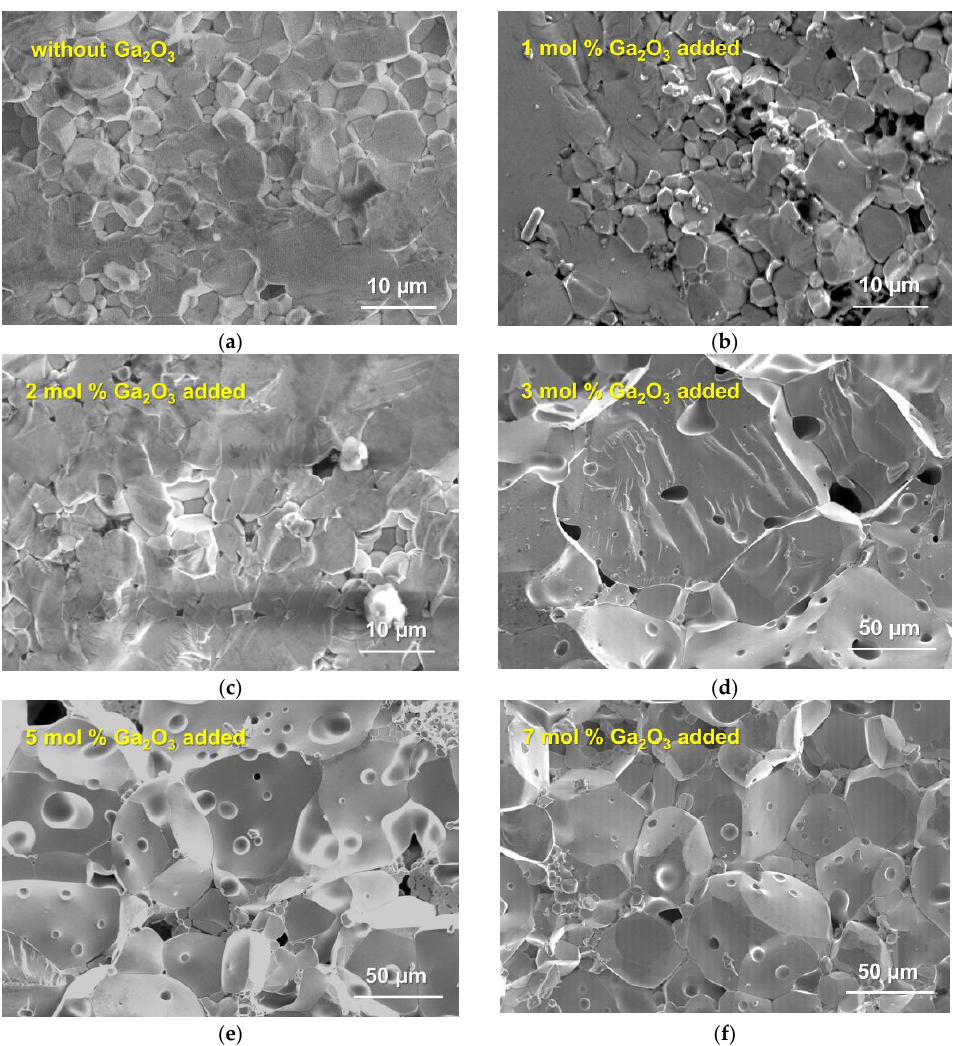
Figure 2. SEM images for fractured cross-sectional surfaces of sintered Ta-doped LLZO: ( a ) without Ga 2 O 3 addition, ( b ) 1 mol % Ga 2 O 3 addition, ( c ) 2 mol % Ga 2 O 3 addition, ( d ) 3 mol % Ga 2 O 3 addition, ( e ) 5 mol % Ga 2 O 3 addition and ( f ) 7 mol % Ga 2 O 3 addition. Note that the scale bars in ( a – c ) are different from ( d – f ).